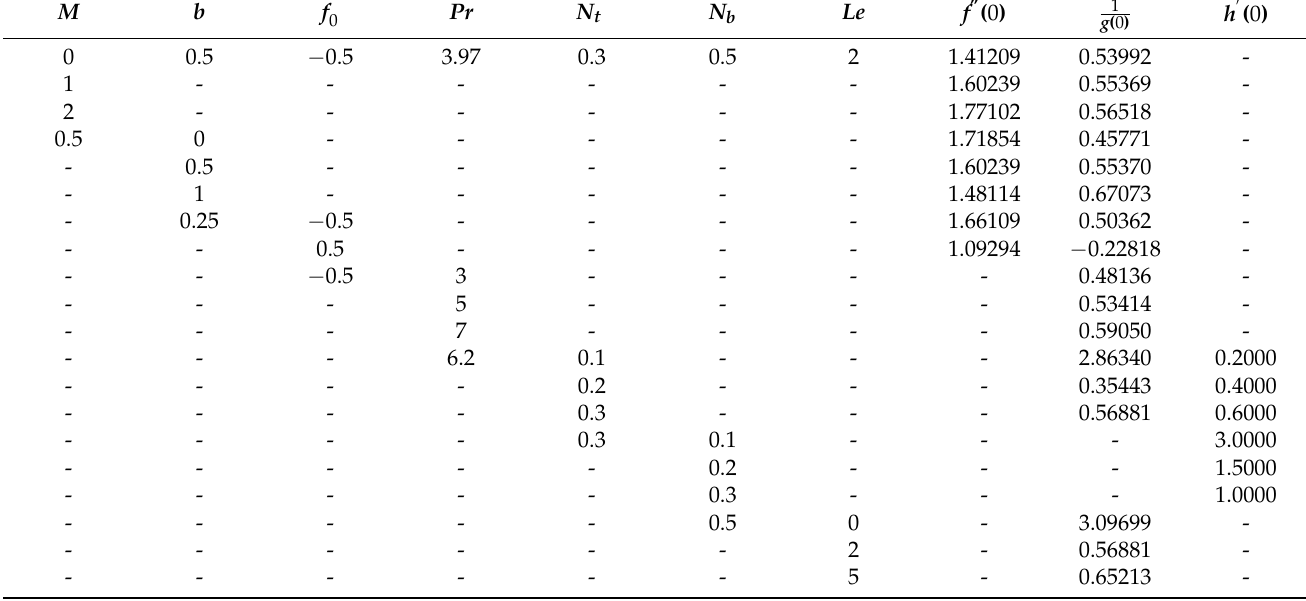
Figure 3. Influence of the parameters ( a ) 𝑁𝑡, ( b ) Prandtl number ( Pr ), and ( c ) 𝑓 (cid:2868) on the dimension- less temperature distribution and numerous choices of emerging parameters. Table 1. The behavior of the physical quantities of skin friction, the Nusselt number, and the Sher- wood number under the variation in physical parameters.